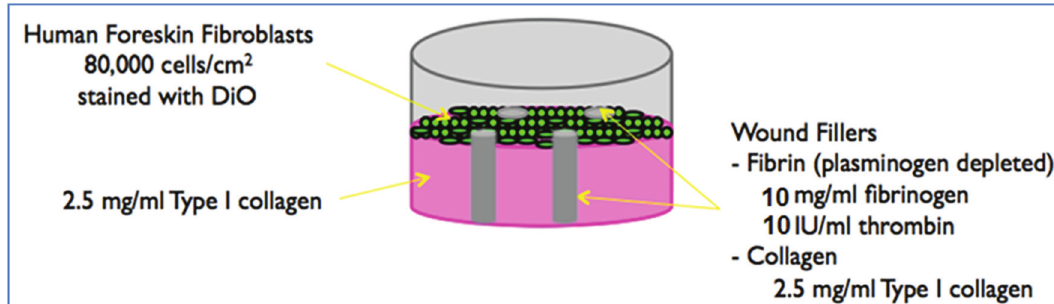
Figure 1. Representation of 3D migration